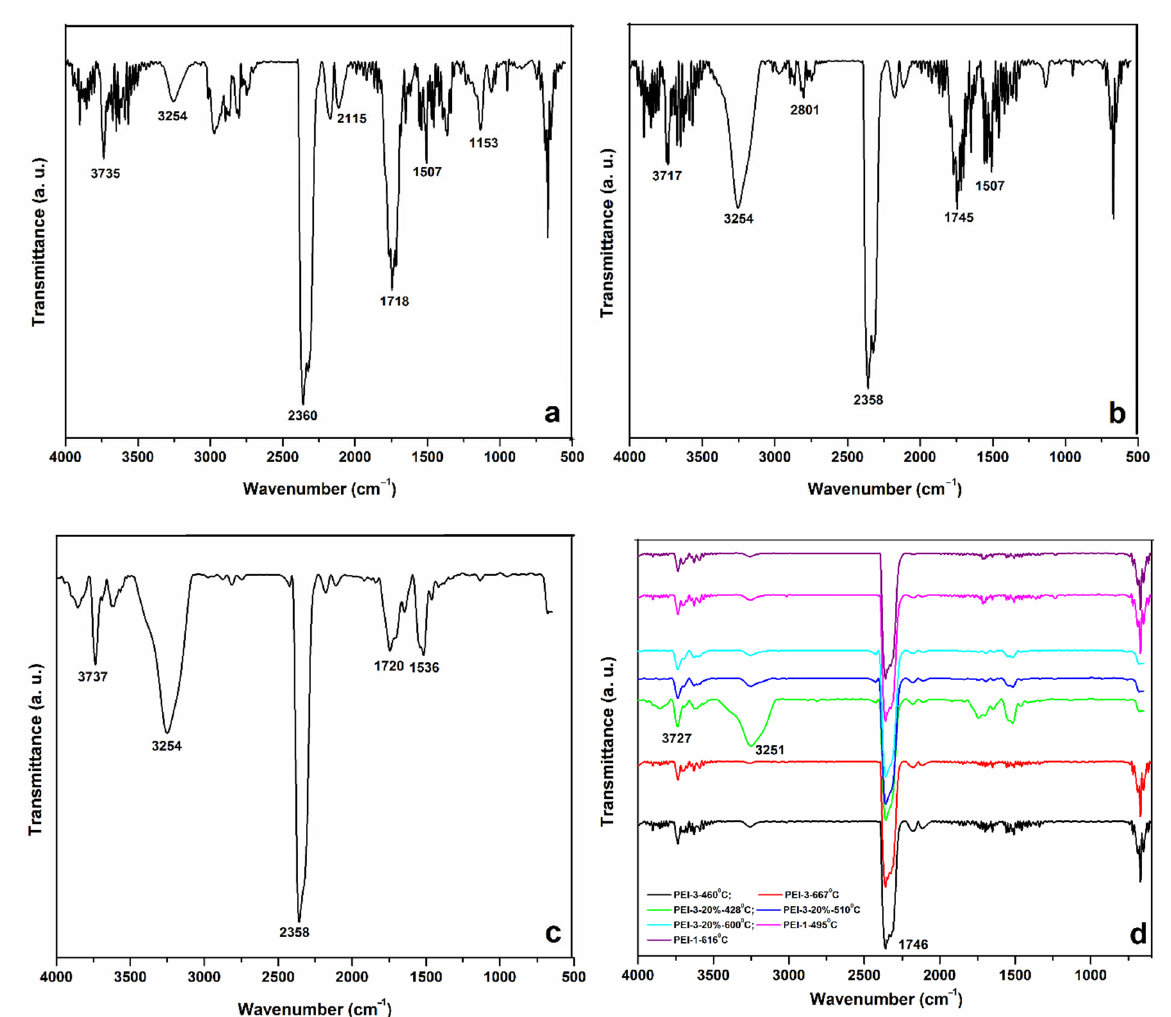
Figure 9. FTIR spectra for PEI-1 at 426 ◦ C ( a ), PEI-3 at 415 ◦ C ( b ), and PEI-3-20% at 395 ◦ C ( c ), and PEI ‐ 1, PEI ‐ 3 and PEI ‐ 3 ‐ 20% at various temperatures for decomposition in air ( d ).